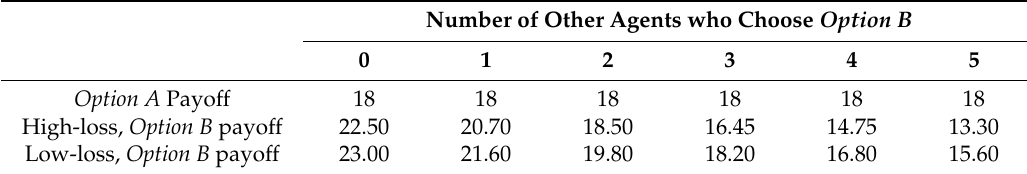
Table 1. Payoffs by type and option choice for endowment = 25.